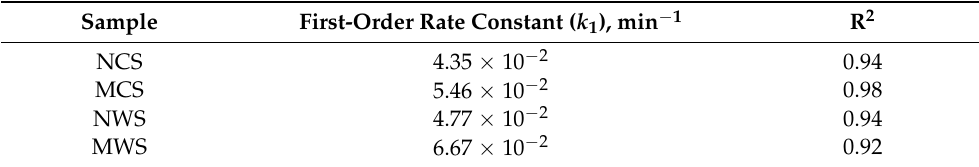
Table 3. First-order rate constants ( k 1 ) and the correlation coefficients (R 2 ) of first-order kinetic plots.